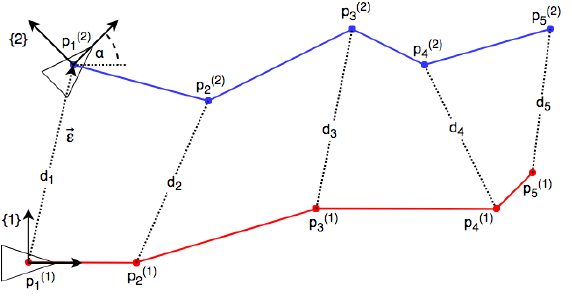
Figure 1. Illustration of the 2D relative pose problem.